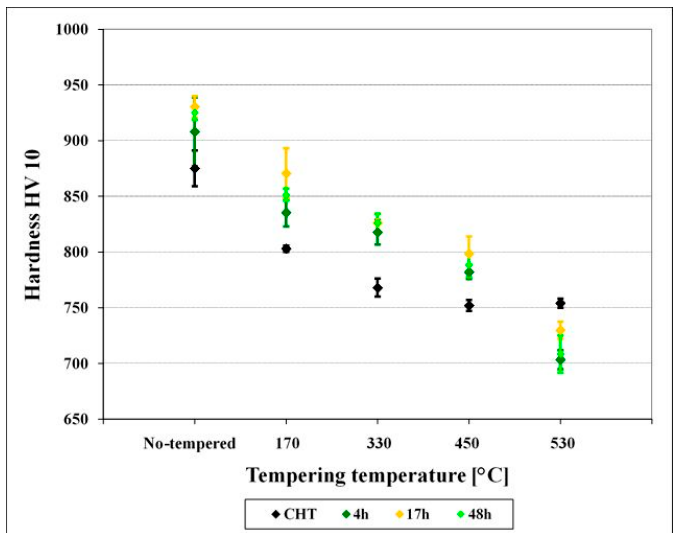
Figure 5. Hardness versus tempering temperature plots for conventionally heat-treated specimens and for specimens after sub-zero treatments at − 75 °C for di ff erent durations.